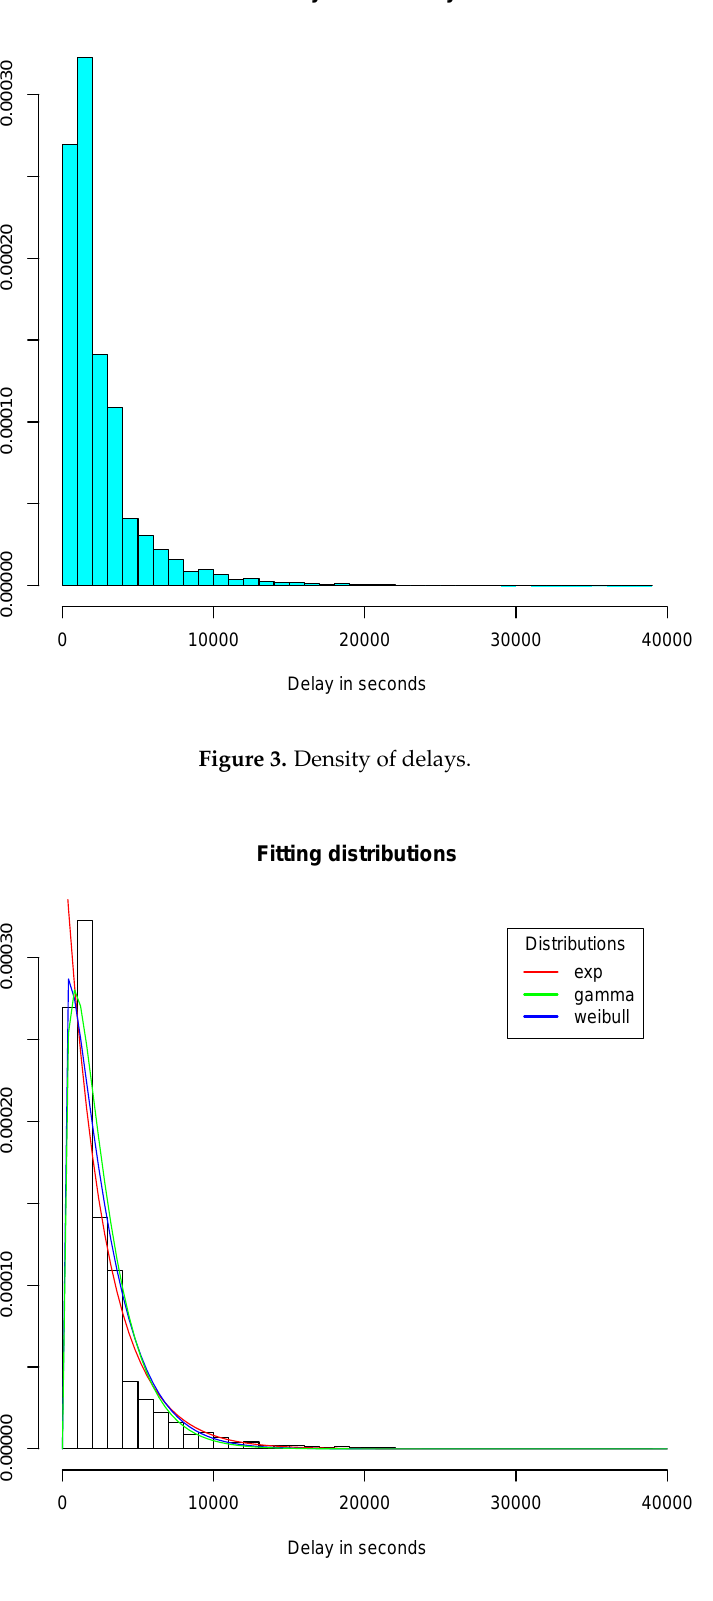
Figure 4. Maximum likelihood